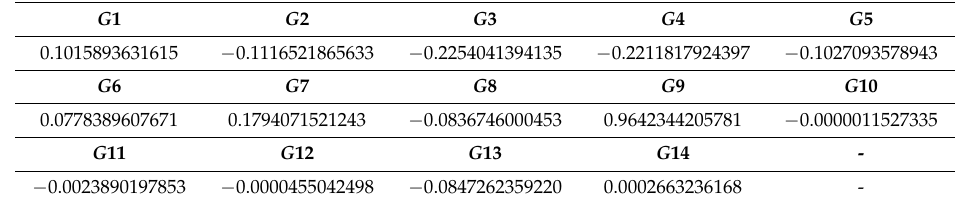
Table 2. Fitting coefficients for the multiparameter model (Equation (4)).